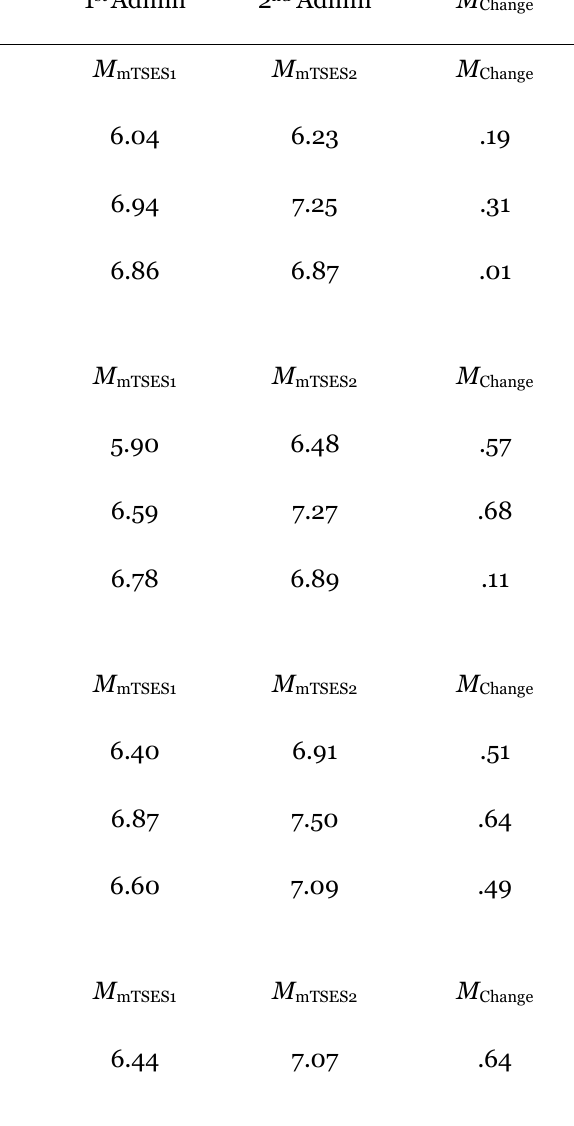
Changes in TSES and mTSES Subdomain Scores Between 1 st and 2nd Administrations